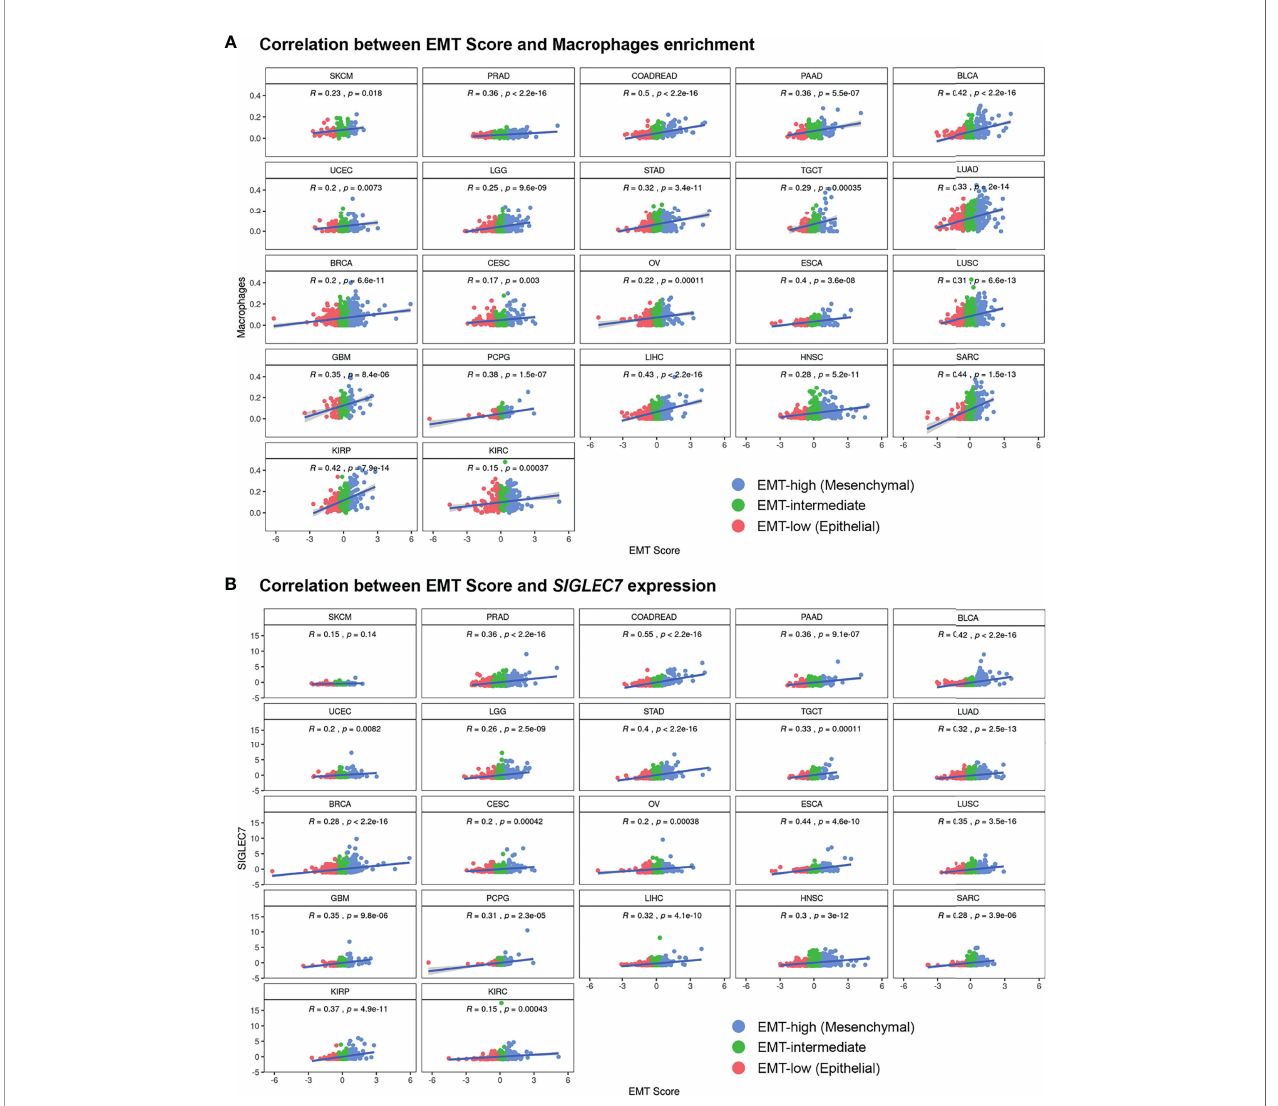
FIGURE 4 | Pan-cancer correlation analysis of EMT Score with (A) xCell enrichment score of Macrophages and (B) gene expression values of immune checkpoint gene SIGLEC7, in all three EMT